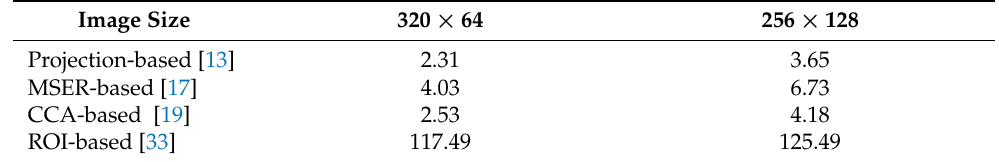
Table 4. Running time (ms) comparison between the proposed approach and the compared methods. Image